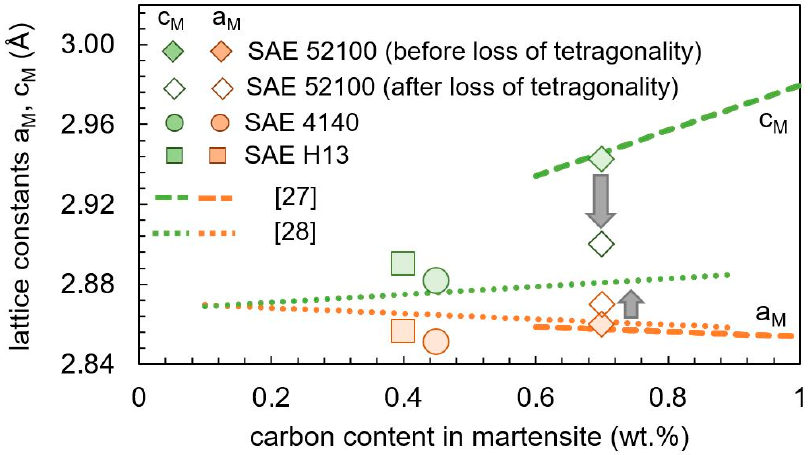
Figure 13. Experimental findings and literature reference [27,28] of lattice parameters a M and c M as function of the carbon content at room temperature. For SAE 52100, the lattice parameters before and after tempering stage (2) are plotted.